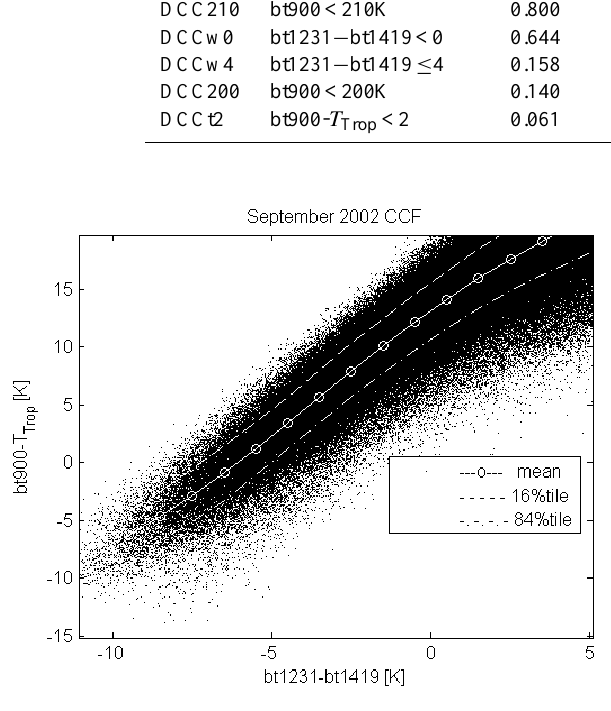
Fig. 2. The relationship between the DTR=bt900- T Trop and DTW=bt1231 − bt1419 is illustrated in a scatter diagram for all Figure 2.The relationship between the DTR = bt900-T Trop and DTW = bt1231-bt1419 is illustrated 657 CCFs collected in September 2002 with in a scatter diagram for all CCF collected in September 2002 with DTR<20K. 658 659